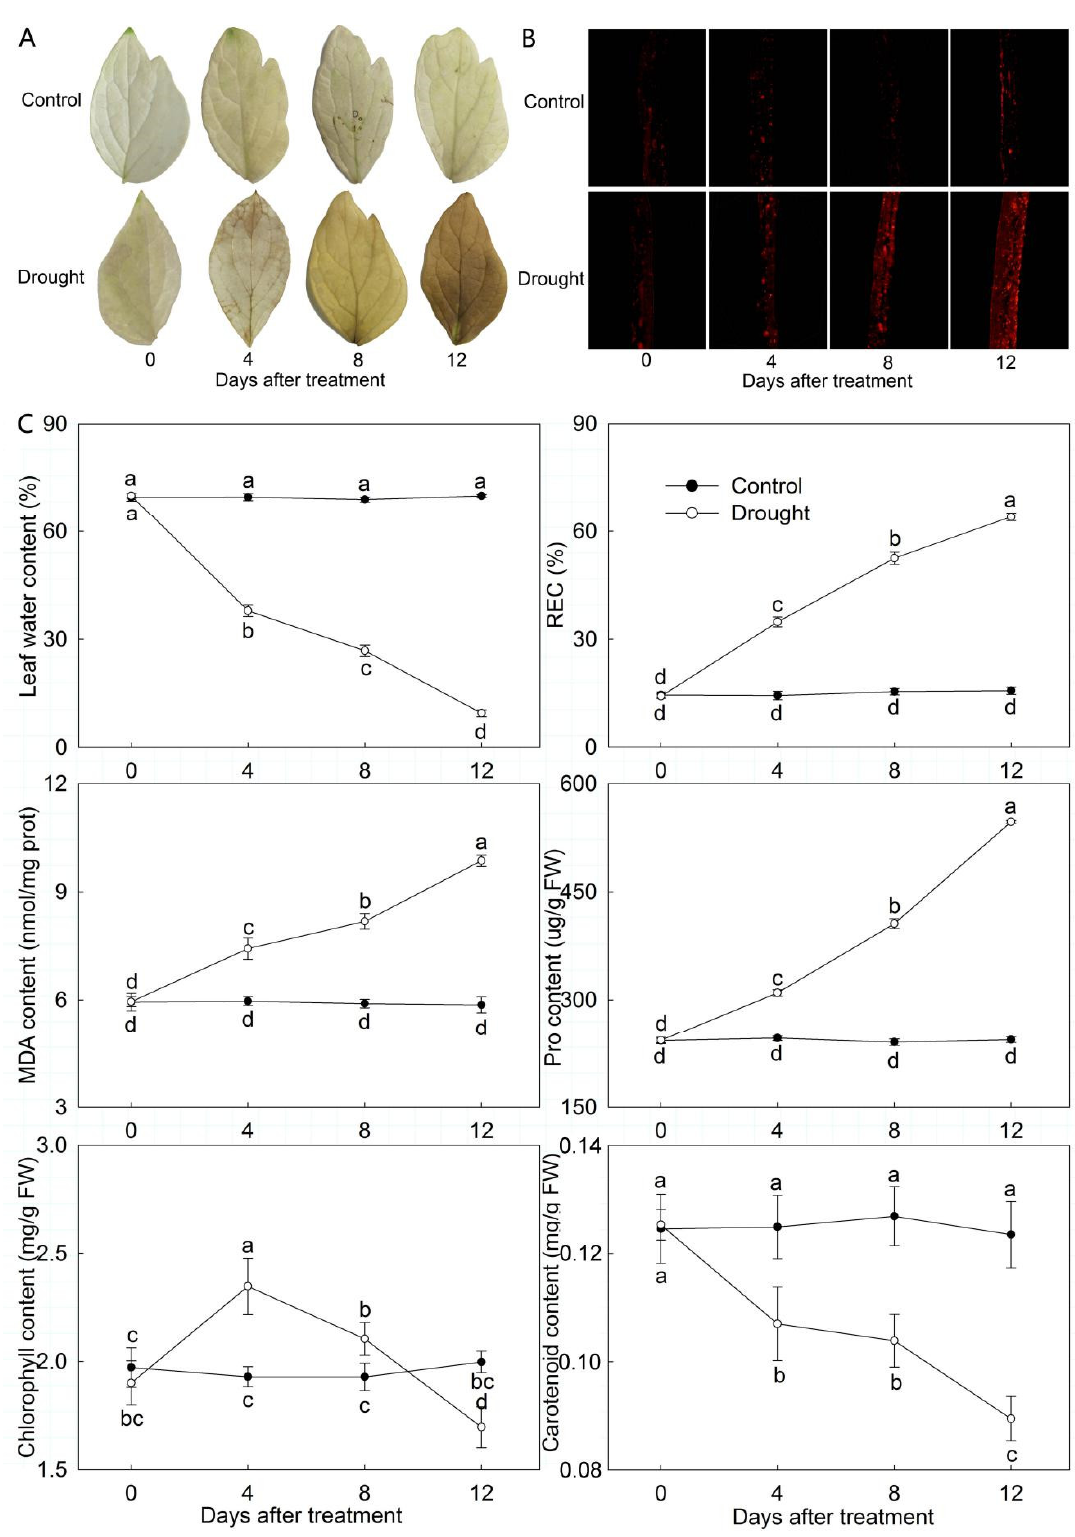
Figure 2. Physiological changes of drought-treated P. ostii and the control. ( A ) H 2 O 2 accumulation was detected by diaminobenzidine (DAB) staining. ( B ) O 2 − accumulation was detected by fluorescence probe. ( C ) Other physiological indices. Values represent mean ± standard deviation (SD), and letters indicate significant differences according to Duncan’s multiple range test ( p < 0.05). REC, relative electrical conductivity; MDA, malondialdehyde; Pro, proline; FW, fresh weight.